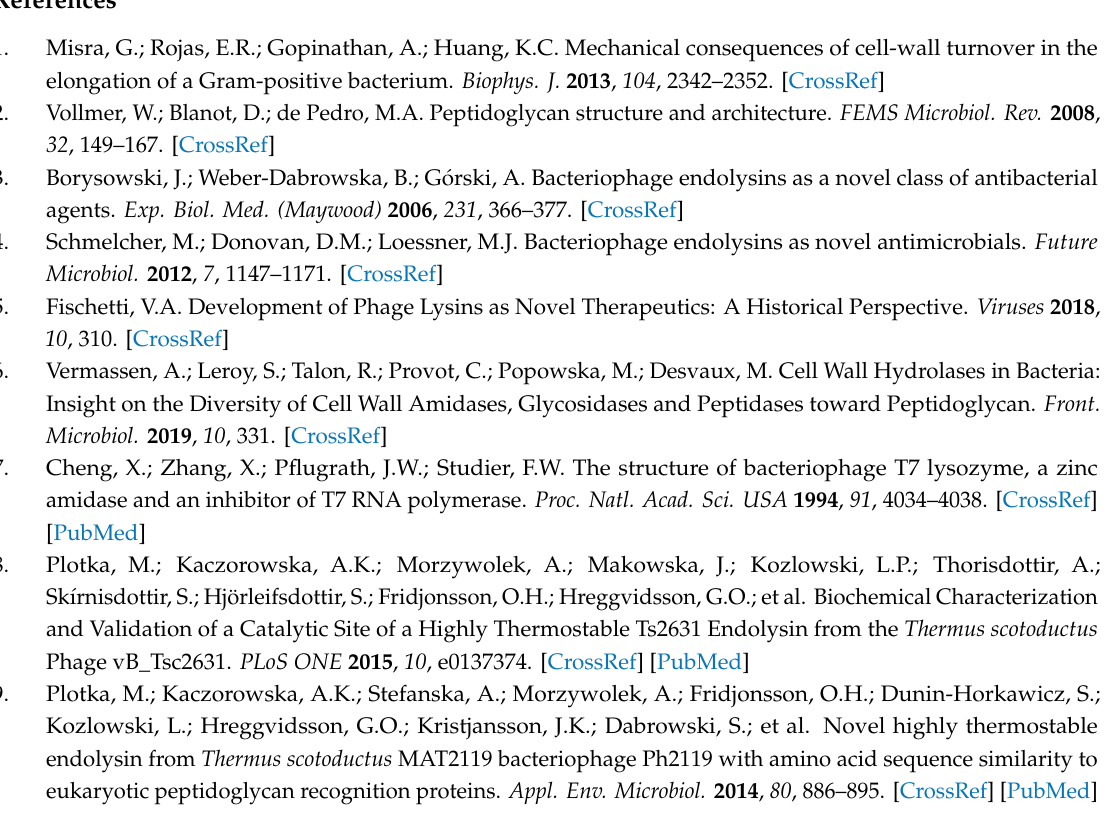
Supplementary Materials: Figure S1. Size-exclusion chromatography analysis of LysC, Table S1. PCR primers used in this study, Table S2. Physicochemical properties of N -terminal region of LysC and Table S3. Antimicrobial peptide prediction of the N-terminal region of LysC. Supplementary materials can be found at http: // www.mdpi. com / 1422-0067 / 21 / 14 / 4894 /